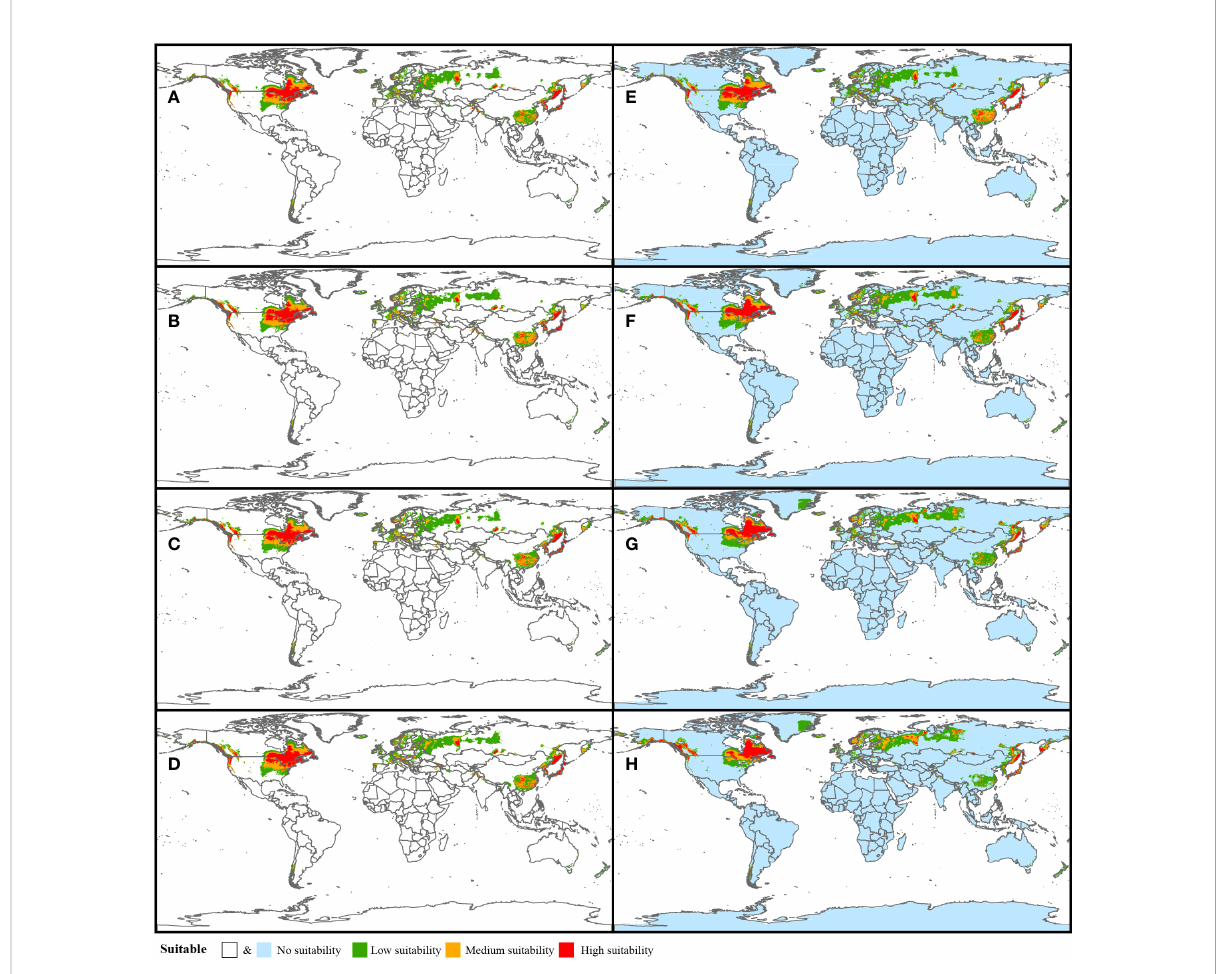
FIGURE 4 Potential habitat prediction of Coptis in the future periods: 2021-2040 (SSP126, A and SSP 585, E ), 2041-2060 (SSP126, B and SSP 585, F ), 2061- 2080 (SSP126, C and SSP 585, G ) and (SSP126, D and SSP 585, H